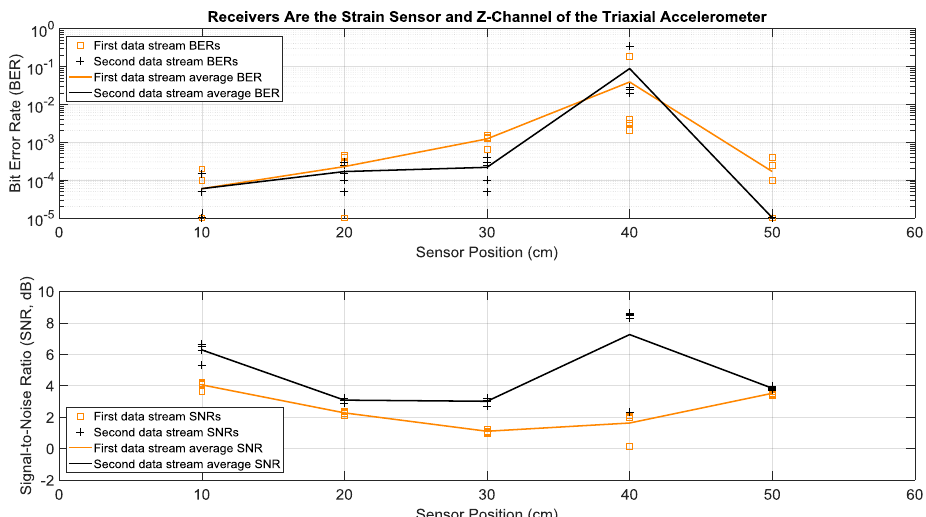
Figure 8. BERs ( top ) and SNRs ( bottom ) at different receiver positions, with two actuators transmitting two data streams simultaneously. The receivers were a strain sensor and the z -channel of a triaxial accelerometer. The piecewise linear graphs represent the average BERs and SNRs for each of the two data streams versus the receiver position.